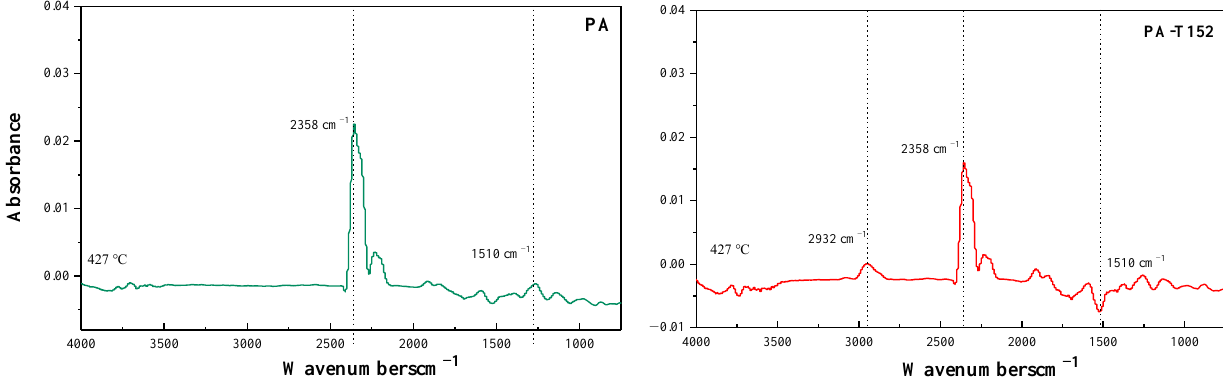
Figure 11. FTIR spectra of PA and PA-T152 at 427